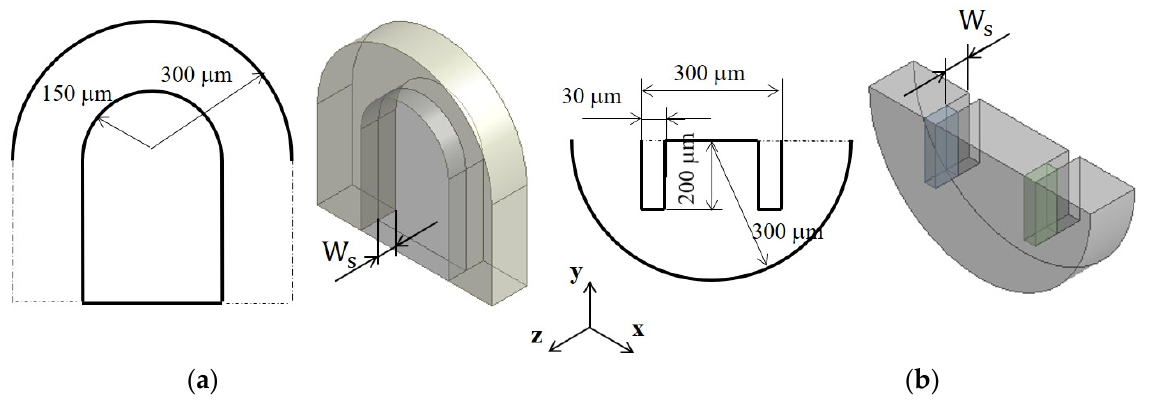
Figure 1. Schematic diagram of two submerged structures (non-proportional): ( a ) Norman window and ( b ) Rectangular